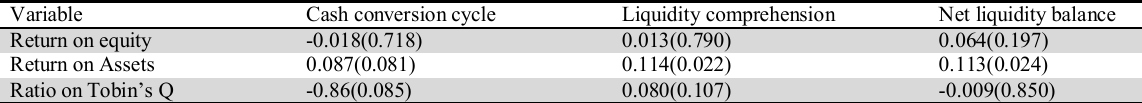
Spearman correlation coefficient among research variables